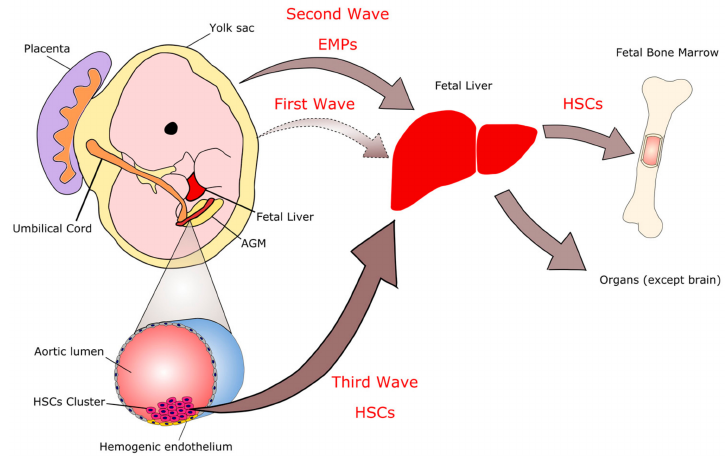
Figure 2. Immune system ontogeny. The colonization of immune cells in the liver occurs in three waves. The first wave originates in blood islets within the yolk sac on embryonic day E7.0. These cells are transient, being replaced by the cells of the second and third waves. The second wave also begins in the yolk sac as erythromyeloid progenitors (EMPs). The third wave gives rise to hematopoietic stem cells (HSCs) from the hemogenic endothelium at the aorta/gonada/mesonephros (AGM) region. EMPs and HSCs seed in the liver and this organ becomes the main place of hematopoiesis in the embryo. From the liver, the immune cells colonize other organs in the body, including the bone marrow, which replaces the hematopoietic function of the liver at the end of gestation and becomes the hematopoietic organ of the